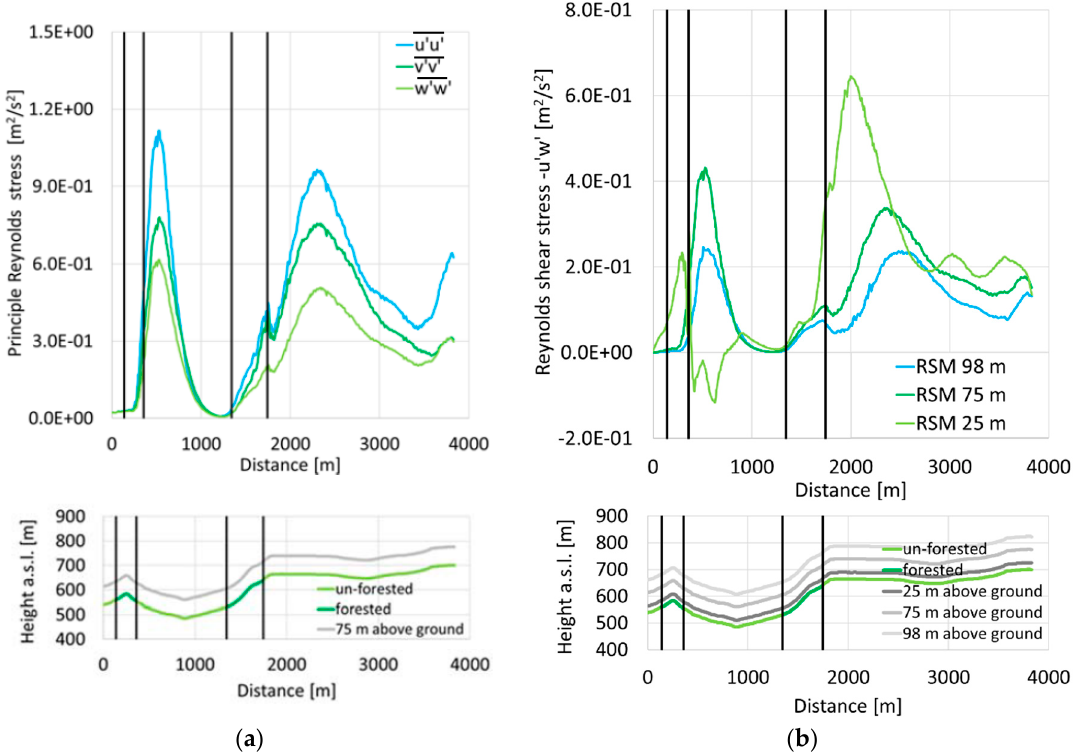
Figure 9. ( a ) Principal Reynolds stresses at a constant distance of 75 m above the ground; ( b ) shear stress − u (cid:48) w (cid:48) at constant distance of 25 m, 75 m, and 98 m above the